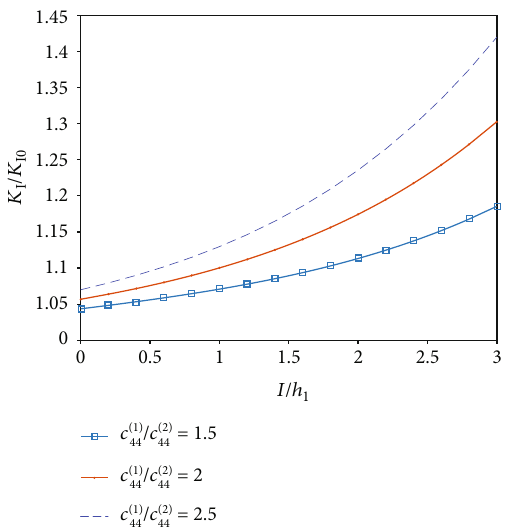
Figure 3: E ff ects of l / h di ff erent c